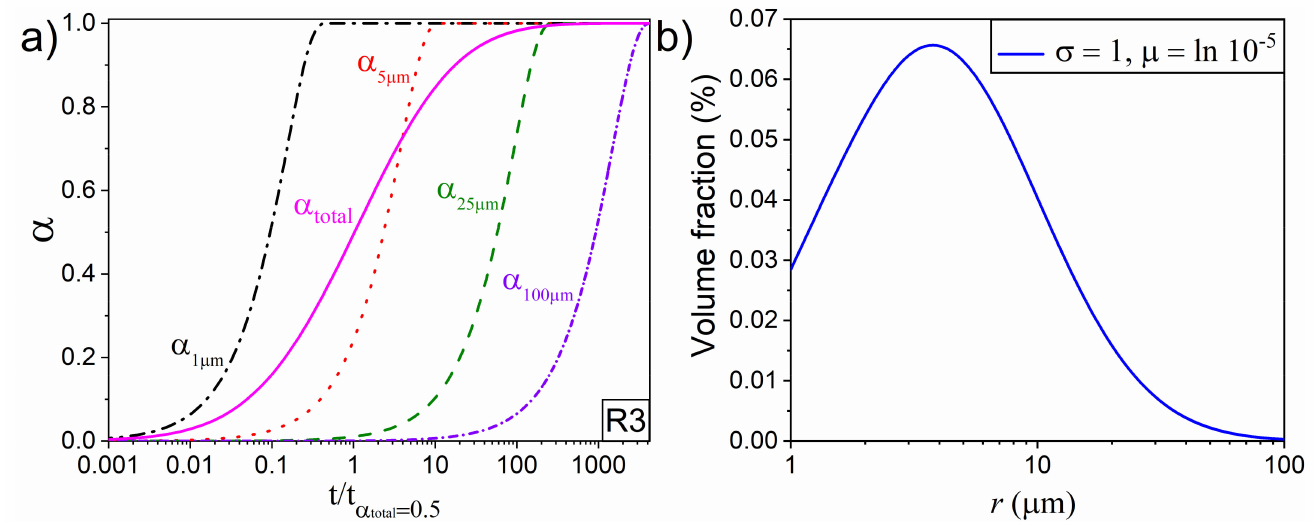
Figure 1. ( a ) Fractional reaction as a function of normalized time for different particle sizes. The overall values for the sample are plotted as a pink solid line. ( b ) Lognormal PSD with σ = 1 and µ = ln10 − 5